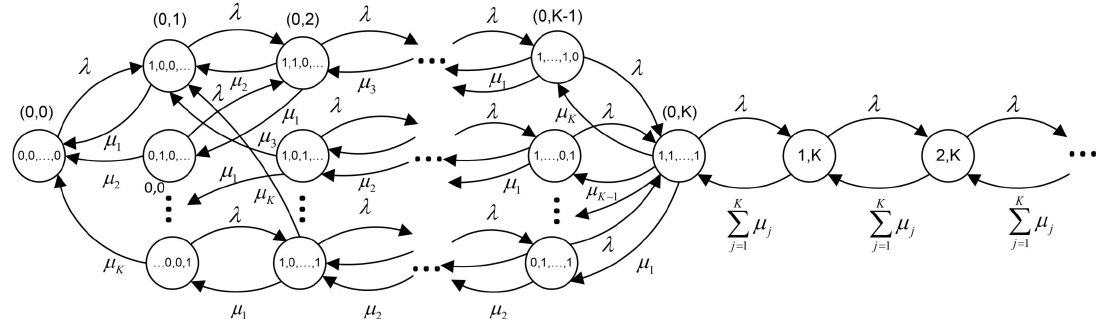
Figure 5. The state transition diagram for the heterogeneous queueing system with the fastest server first (FSF) policy.